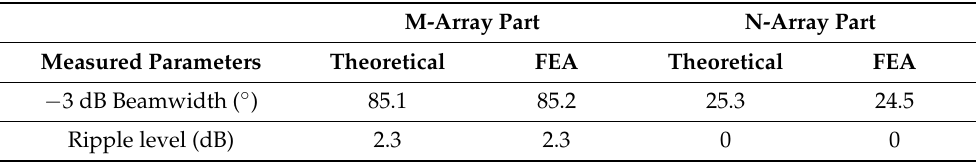
Figure 9. Three-dimensional beam pattern of the 5 × 55 conformal array. Table 6. Quantitative comparison between the theoretical and FEA results.